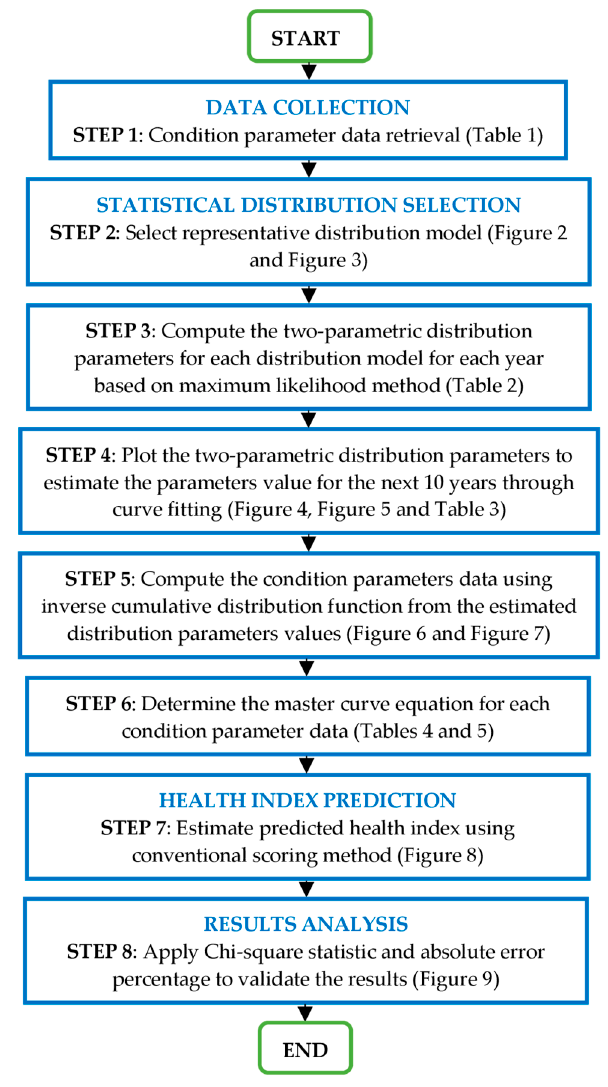
Figure 1. Modelling framework for future health index of the transformer population.